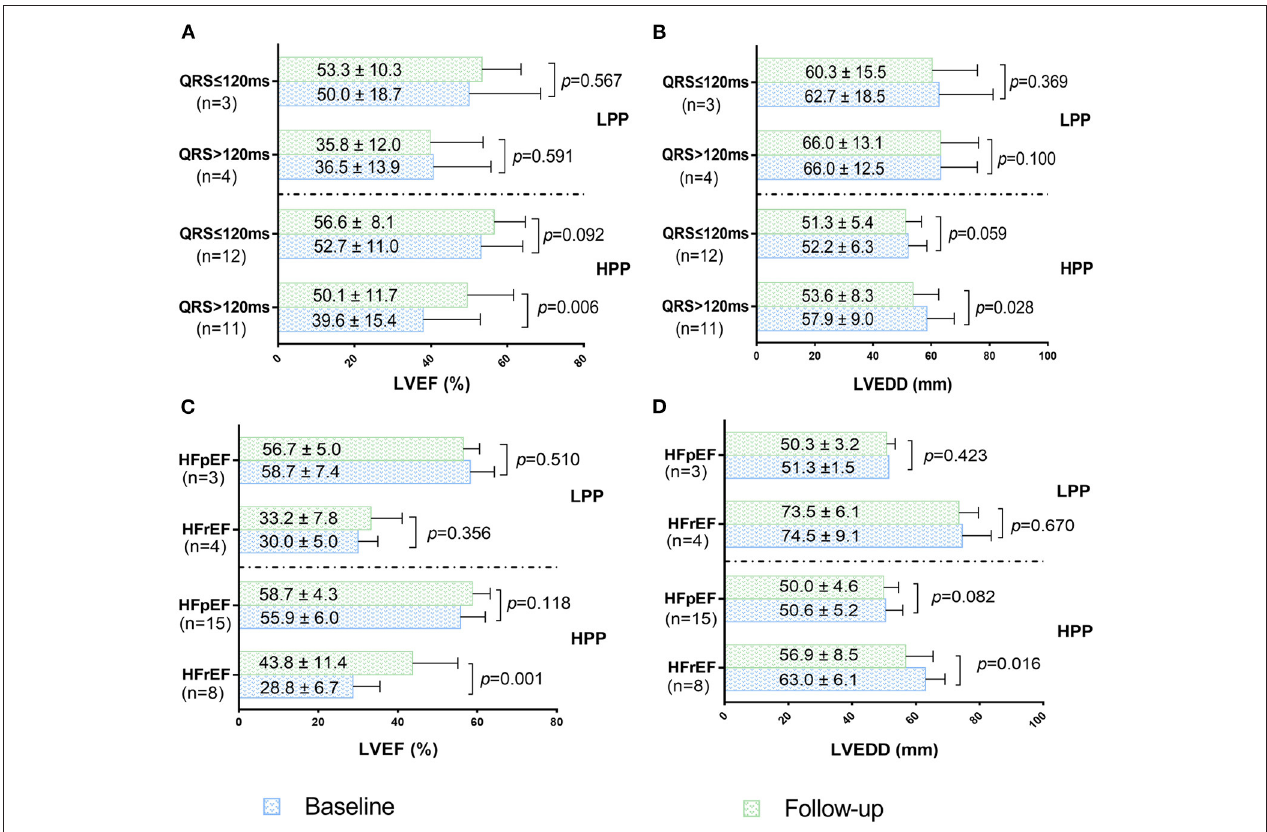
FIGURE 5 | LVEF changes of patients with wide QRS complex and narrow QRS complex under HPP and LPP (A) . LVEDD changes of patients with wide QRS complex and narrow QRS complex under HPP and LPP (B) . LVEF changes of patients with HFpEF and HFrEF under HPP and LPP (C) . LVEDD changes of patients with HFpEF and HFrEF under HPP and LPP (D) . HPP, high pacing proportion; LPP, low pacing proportion; LVEF, left ventricular ejection fraction; LVEDD, left ventricular end diastolic dimension; HFpEF, heart failure with preserved ejection fraction; HFrEF, heart failure with reduced ejection